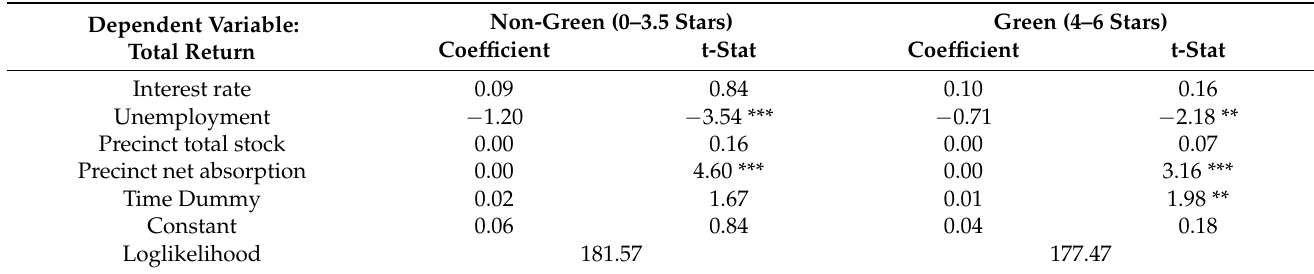
Table 11. Regression results of non-green (0–3.5 stars) and green (4–6